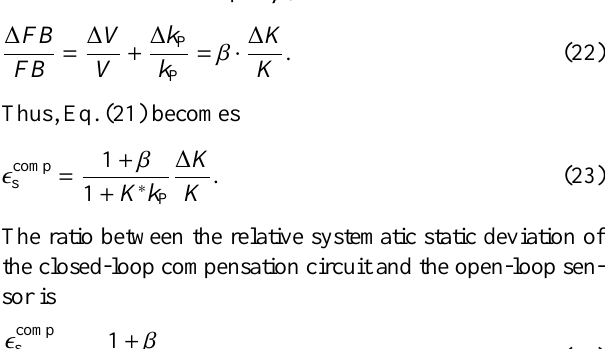
Figure 13. Closed-loop compensation circuit where the quasi-static sensor part is characterized by a sensitivity ˜ K , describing the dy- namics of the drift process by a drift